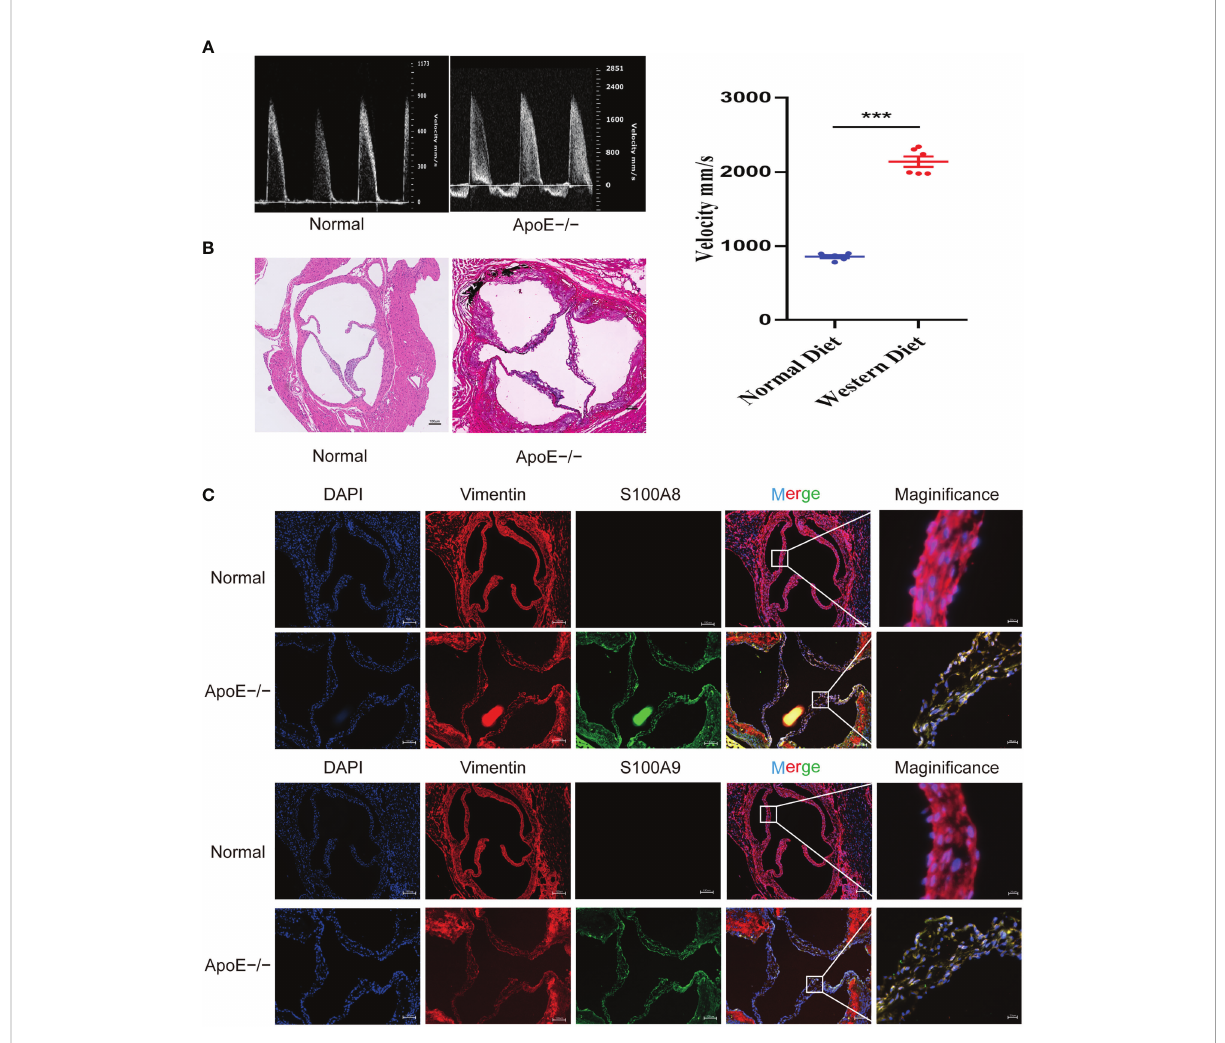
FIGURE 11 Validation of S100A8 and S100A9 expression in ApoE − / − mice. (A) Echocardiography of hearts from APOE − / − mice in each group. Quanti fi cation of fl ow-velocity maximum of the aortic valve, mm/s. Blue represents a normal diet, and red represents a western diet administered to APOE − / − mice. (B) Von Kossa staining of the mouse valves. The areas of valve calci fi cation are stained black. (C) Immuno fl uorescence showed increased S100A8 and S100A9 expression levels in aortic valve tissues from ApoE − / − mice fed a western diet for 4 months. *** P< 0.001 when two groups were compared as indicated or compared to the corresponding